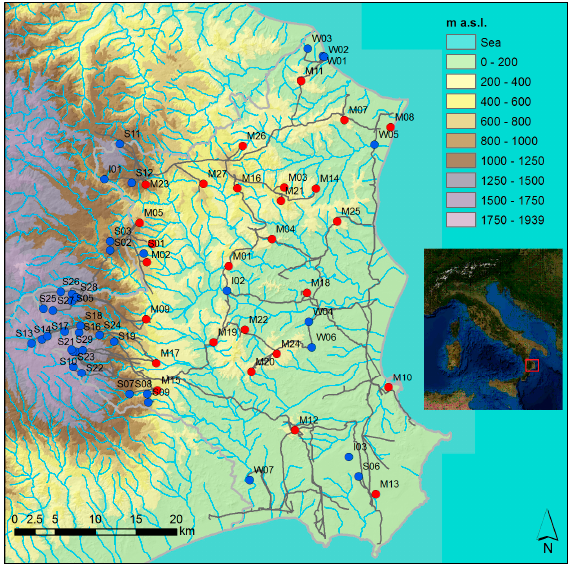
Figure 1. Case study area. Blue circles represent source nodes; red circles represent destination nodes; dark gray lines represent existing conveyance pipes; and light gray lines represent administrative borders.